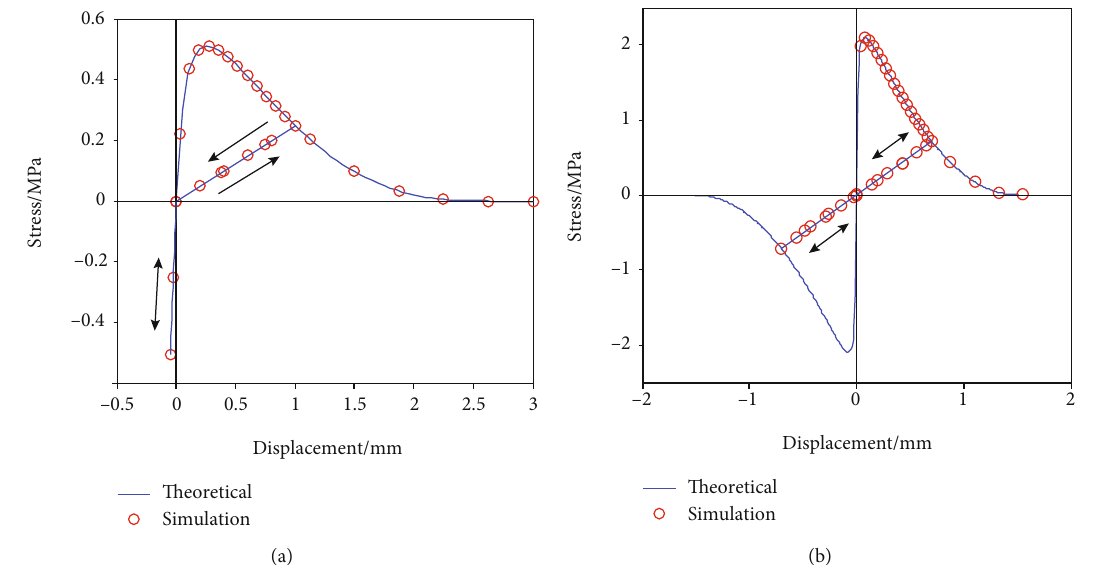
Figure 9: Stress results and its theoretical value of user element versus displacement for pure mode I (a) and pure mode II (b).